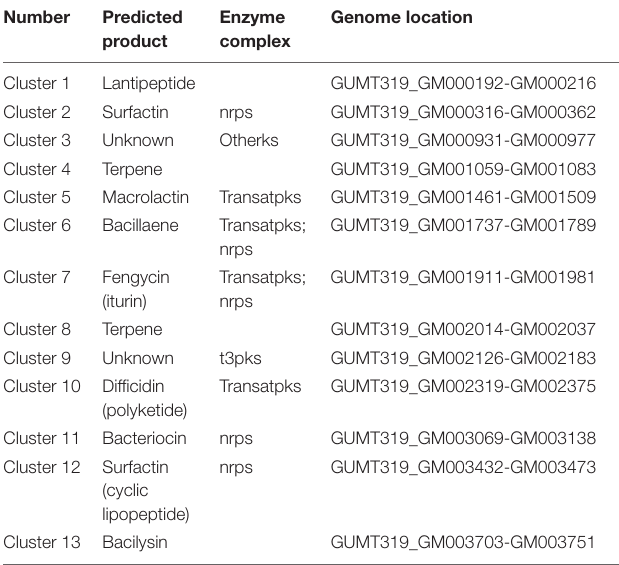
TABLE 2 | Antimicrobial gene clusters present in B. velezensis